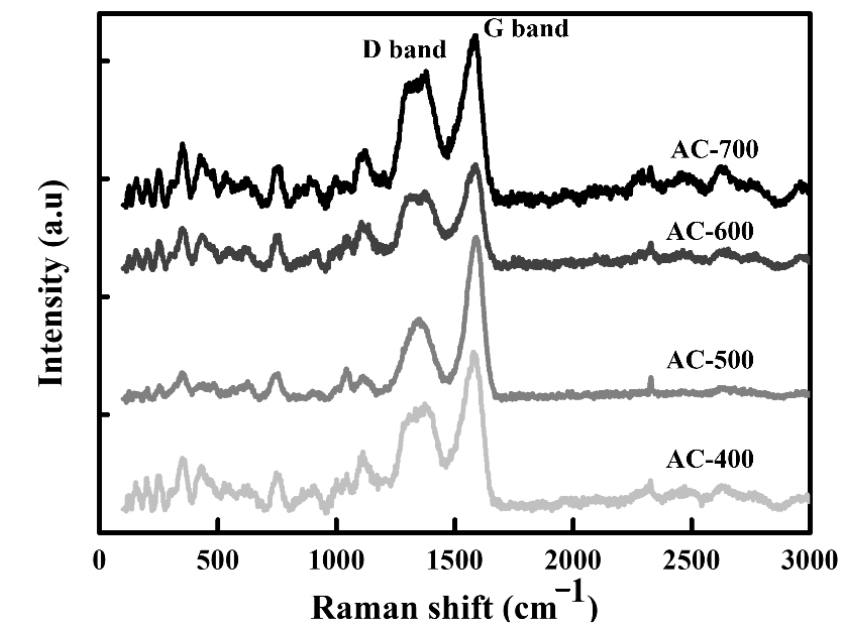
Figure 2. Raman spectra obtained for AC-400, AC-500, AC-600, and AC-700, as indicated.